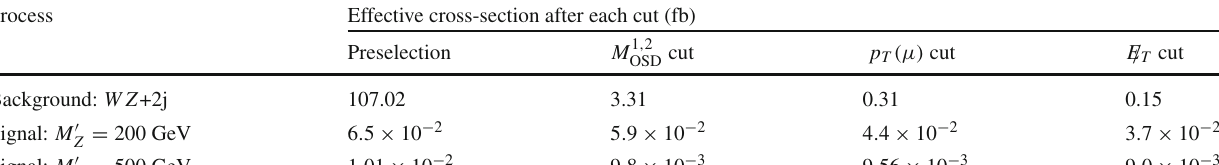
√ s = 14 TeV for both signal and Table 3 Effective cross-section at background for 3 μ + E T / channel after each cut described in the next . The signal benchmarks correspond to the couplings g μμ = 0 . 20, g bb =